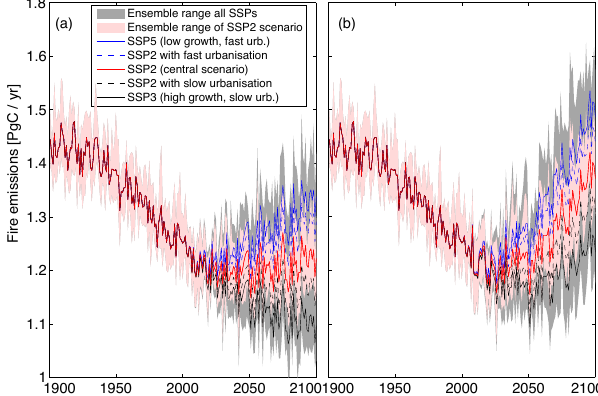
Figure 1. Simulated global wildfire emissions 1900 to 2100. Shaded areas are for the range of ensemble members either across all ESMs using only the central population scenario SSP2, or across ESMs and all population scenarios. Lines show ensemble averages for spe- cific population scenarios. (a) RCP4.5 greenhouse gas concentra- tions and climate change; (b)